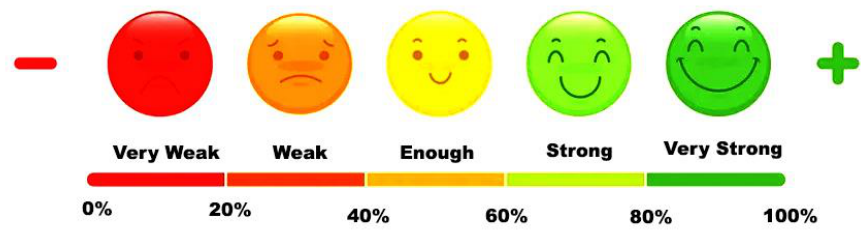
Figure 4. Reference to changing percentages of data.